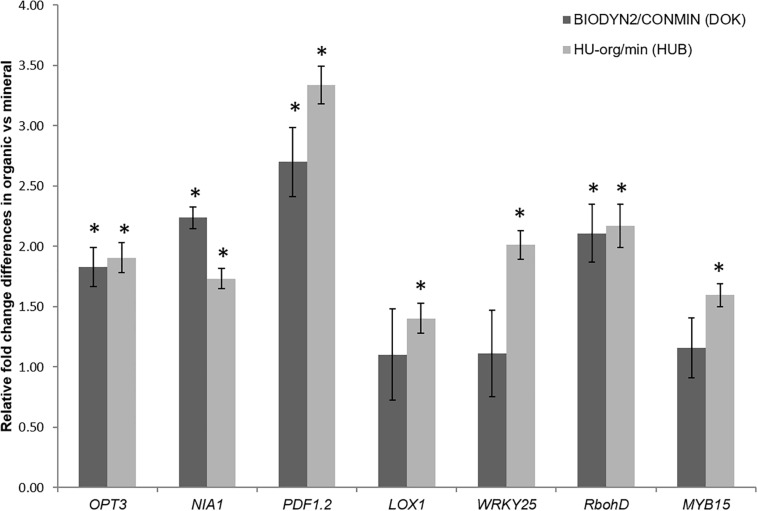
Upregulated genes in shoots of lettuce grown over a period of nine weeks in soils with long-term organic (HU-org, BIODYN) in comparison to mineral (HU-min, CONMIN) fertilization history. The 2–ΔΔCt method (Livak and Schmittgen, 2001) was employed for relative quantification (n = 4) by qPCR (see section “Materials and Methods”). Means ± standard errors of four independent replicates showing relative changes in gene expression of plants grown under long-term organic vs. mineral fertilization. Only genes showing significant (p ≤ 0.05) differences in ΔCt values between organic vs. mineral fertilization within each site as revealed by Tukey’s HSD pairwise test are shown (denoted by asterisks). Gene names, putative functions and primer sequences are described in Supplementary Table 1.